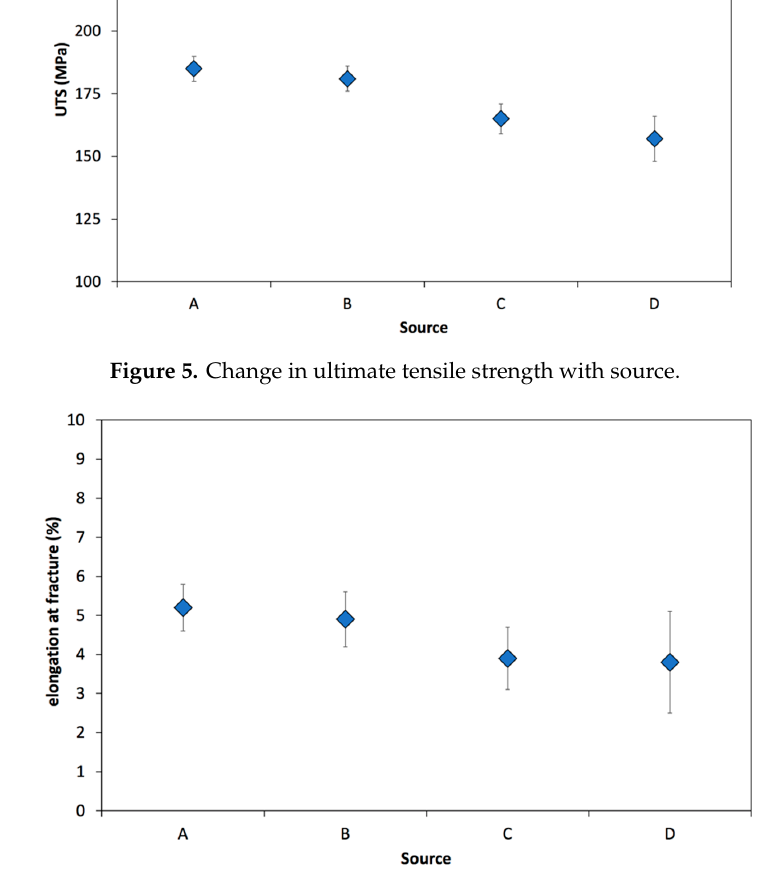
Figure 6. Change in elongation at fracture with source.